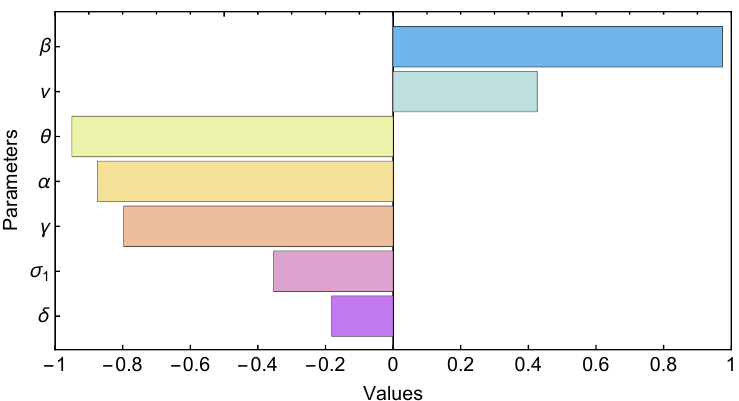
Figure 10. Correlation between the basic reproduction number ( R 0 ) and the model parameters β , ν , θ , α , γ , σ 1 , and δ